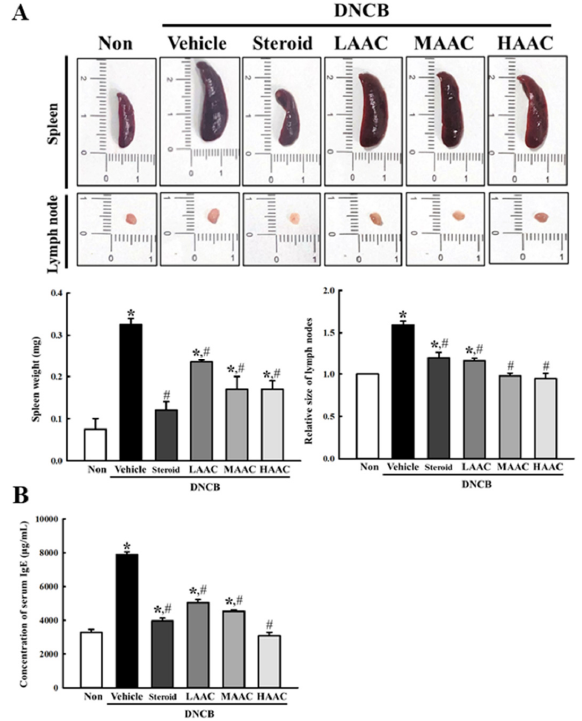
Figure 8. Alterations of IgE-mediated symptoms in DNCB-treated BALB/c mice spread with AAC. ( A ) Weight of immune organs. After the collection of the spleen and lymph node, their actual images were taken with a digital camera, and their weights were measured using an electrical balance. ( B ) The concentration of IgE was quantified in serum using an enzyme-linked immunosorbent assay (ELISA) with a detectable concentration range of 10–5000 ng/mL. Organs and serum were collected from four to six mice per group, and the weight of organs and IgE concentrations were analyzed in duplicate. All values in the results are represented as the means ± standard deviation (SD). * indicates statically significance compared to the non-treated group, while # indicates statistical significance compared to the DNCB+Vehicle-treated group. Abbreviations: AA, abietic acid; DNCB, 2,4-dinitrochlorobenzene; LAAC, low concentration of AA cream; MAAC, medium concentration